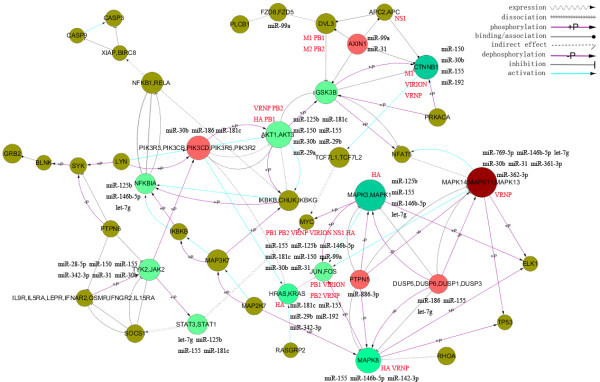
Influenza virus-related regulatory network. KEGG pathway analysis was performed on cellular genes identified as important for influenza virus replication. The interactions between nodes in these enriched KEGG pathways were summarized to construct a combined pathway network. The degree level of each gene is represented by the size of the node. The color gradient of the green nodes, from light to dark, shows the value of in-degree of the receivers, from low to high; meanwhile, the color gradient of the red nodes, from light to dark, shows the value of out-degree of the regulators, from low to high. The nodes with degree more the 3 in the combined network were showed in the core sub-network. MiRNAs were located near their targets, and so were the virus proteins which were represented by red fonts.